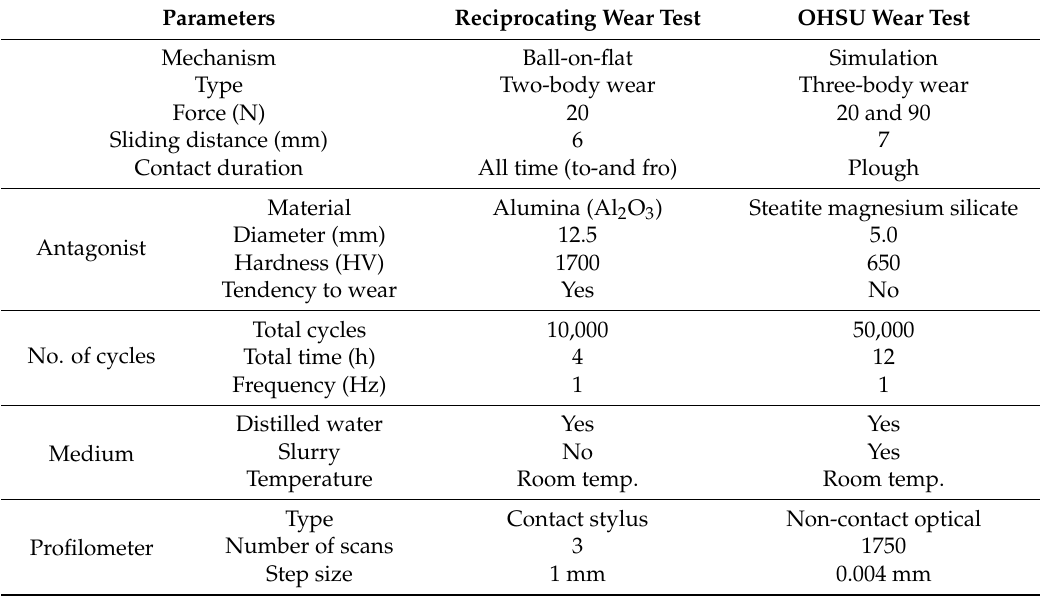
Table 4. A comparison of the various parameters used in reciprocating wear test and the OHSU wear